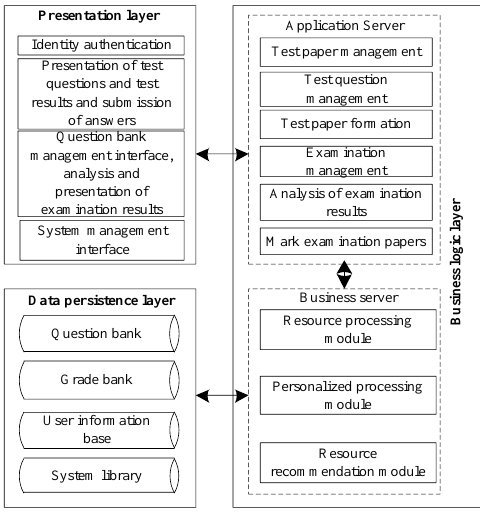
Figure 2. overall system